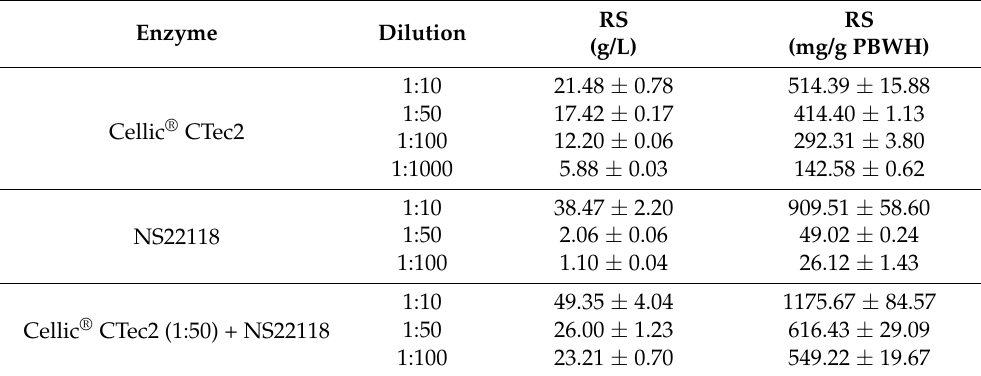
Table 6. Hydrolysis of pretreated biomass of water hyacinth (PBWH) with six commercial enzyme complexes diluted enough to reach 5.62 U/mL, using carboxymethyl cellulose (CMC) as substrate. Enzyme Activity Fold RS RS Yield Complex (U/mL) Dilution (g/L) (mg RS/g PBWH) NS22086 262.32 ± 0.03 46.66 17.97 ± 1.55 428.65 ± 33.11 NS22083 210.50 ± 0.02 37.44 22.84 ± 0.68 553.57 ± 15.61 NS22118 59.15 ± 0.05 10.52 39.60 ± 3.14 954.83 ± 83.91 NS22119 116.77 ± 0.03 20.77 22.35 ± 0.40 534.85 ± 7.28 NS22002 65.55 ± 0.01 11.66 8.82 ± 0.72 210.50 ± 15.57 Cellic ® CTec2 281.11 ± 0.05